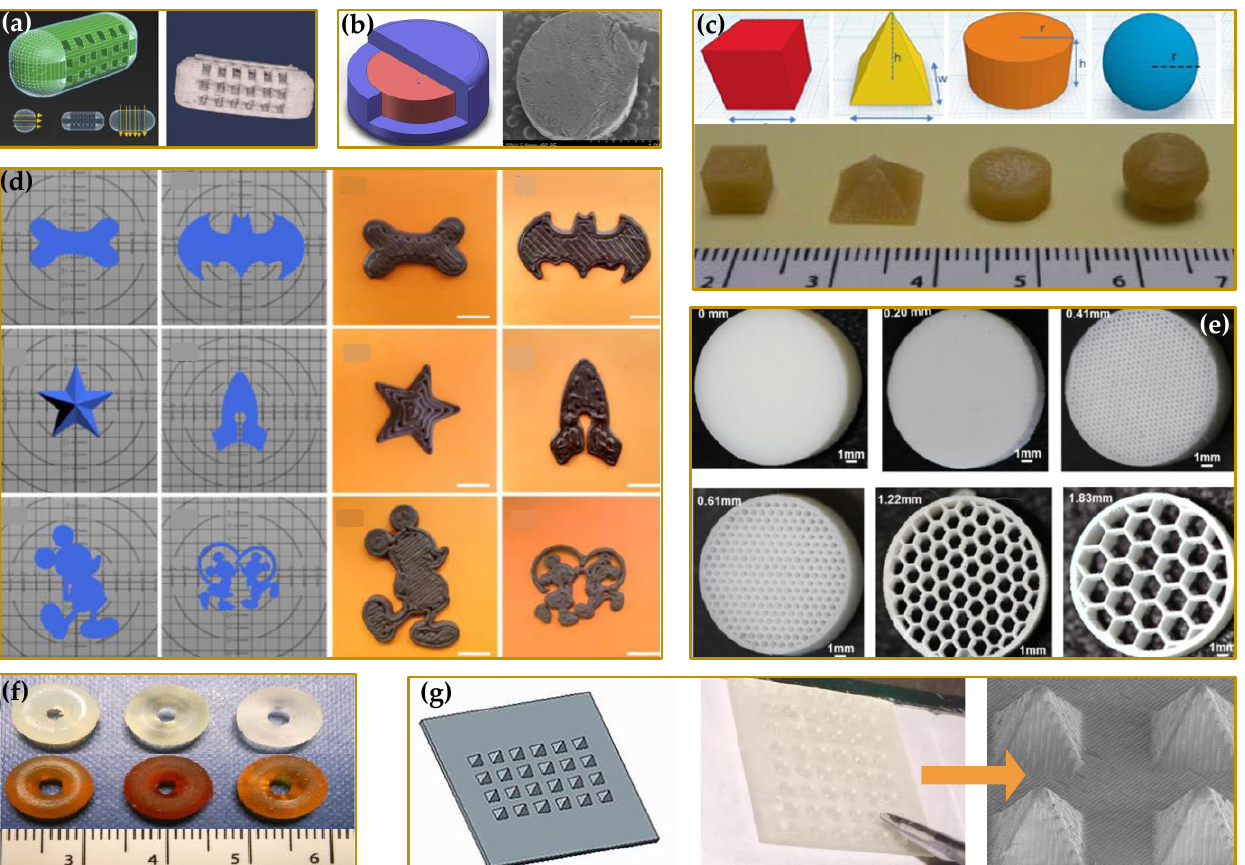
Figure 1. Examples of 3D printed products for drug delivery. ( a ) Channeled tablet. Reprinted with permission from reference [35]; copyright (2017) Elsevier B.V. ( b ) Duo Tablet. Reprinted with permission from reference [36]; copyright (2017) Elsevier B.V. ( c ) Cube, pyramid, cylinder and sphere-shaped tablets. Reprinted with permission from reference [37]; copyright (2015) Elsevier B.V. ( d ) Chewable chocolate-based oral dosage forms. Reprinted with permission from reference [38]; copyright (2020) Elsevier B.V. ( e ) Tablets with honeycomb architectures. Reprinted from reference [39]; copyright (2017). ( f ) Donut-shaped tablets. Reprinted with permission from reference [40]; copyright (2016) Elsevier B.V. ( g ) Microneedle patch. Reprinted with permission from reference [41]. copyright (2018) Elsevier B.V.